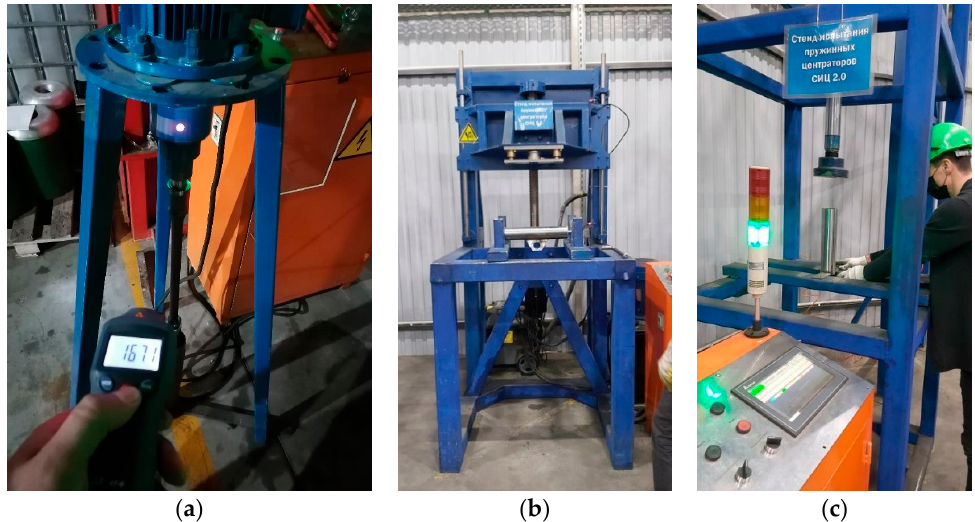
Figure 7. Testing the TsNShP centralizer: ( a ) on a vertical bench with an electric motor and a frequency converter, ( b ) on the SITs-2 horizontal bench with a pipe simulator, and ( c ) on the SITs-2 vertical test bench for bow spring centralizers.